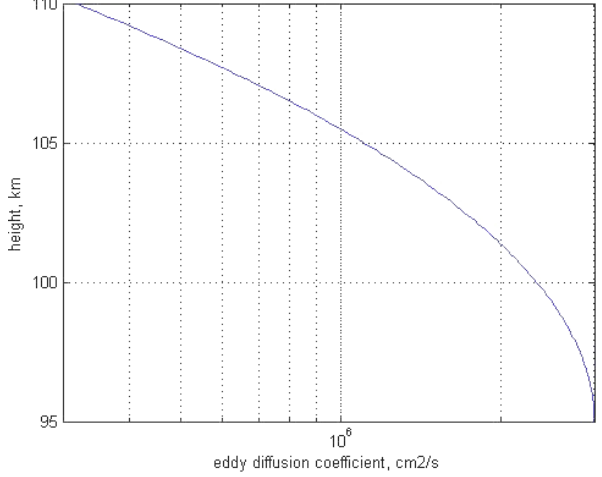
Fig. 4. Height profile of the eddy diffusion coefficient correspond- ing to the [He] height distribution shown by the dashed curve in Fig.